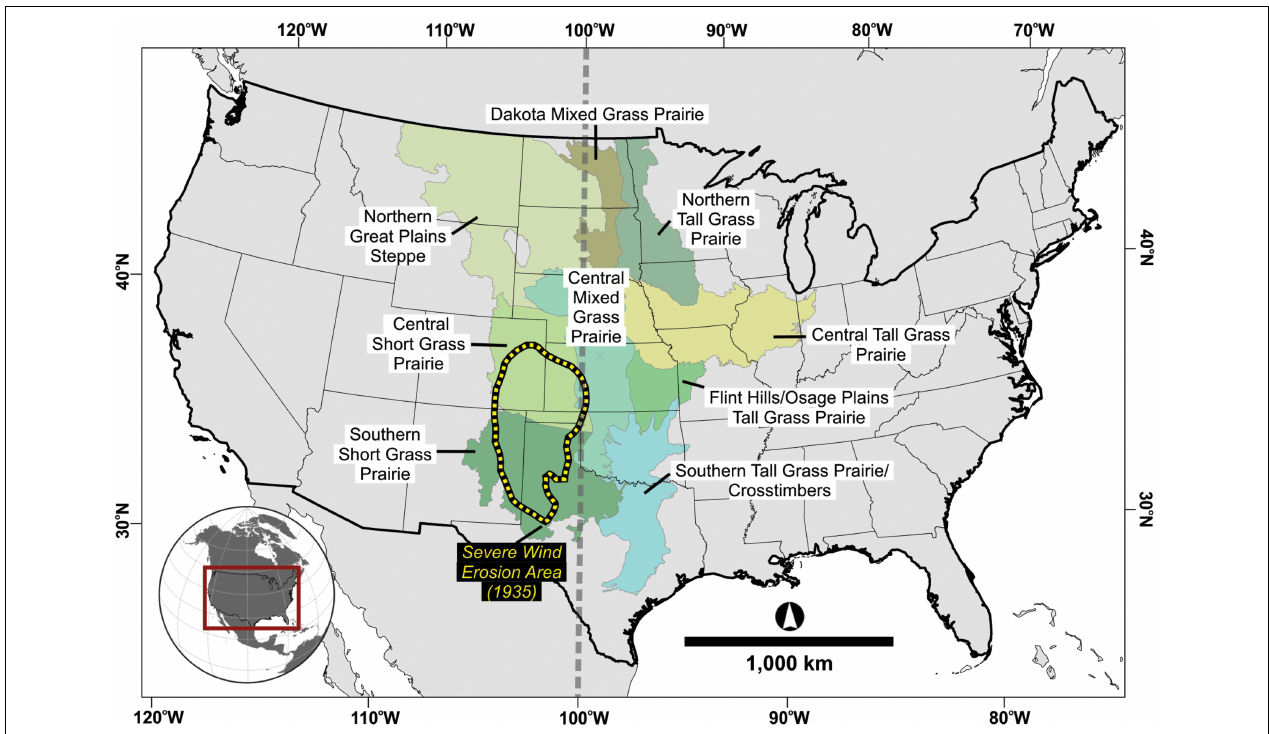
FIGURE 1 | Location of the United States Great Plains delineated by terrestrial ecoregion (The Nature Conservancy [TNC] et al., 1995), with the 100th meridian demarcated by a dashed line and the classically recognized area of severe wind erosion at its maximum extent in 1935 (Worster, 1982; Cunfer,